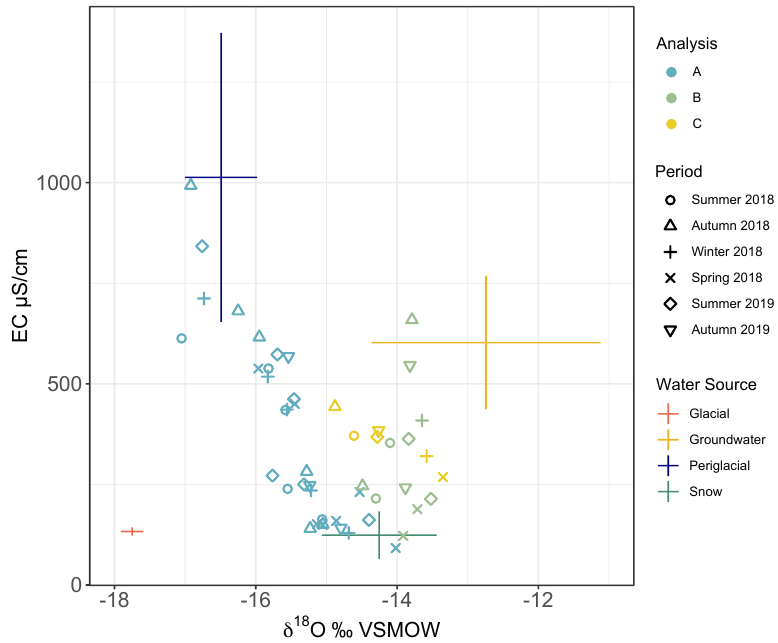
Figure 4. “Simmr” isospace plot of di ff erent water sources contributing to the upper Aconcagua River basin. The di ff erent water source references (i.e., glacial, periglacial, groundwater and snow) and samples used for each model analysis (A, B and C) were plotted in color. Shapes were used to represent the six sampling periods and water source references. The sources are identified by the colors (i.e., glacial in red up-oriented, groundwater in orange, periglacial in night blue and snow in dark green). Vertical and horizontal bars represented the standard deviation of the water